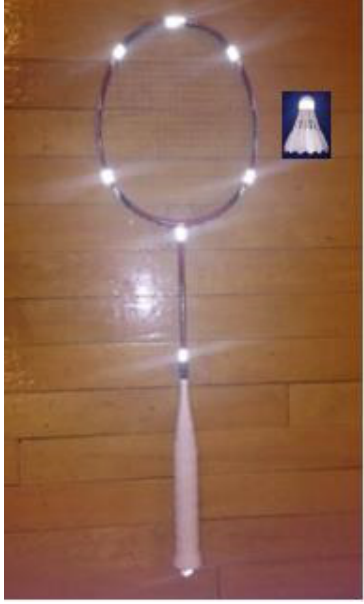
Figure 2. Racket and shuttlecock marker locations.